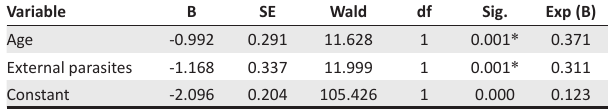
TABLE 3: Variables in the final binomial multivariable logistic regression model. Variable